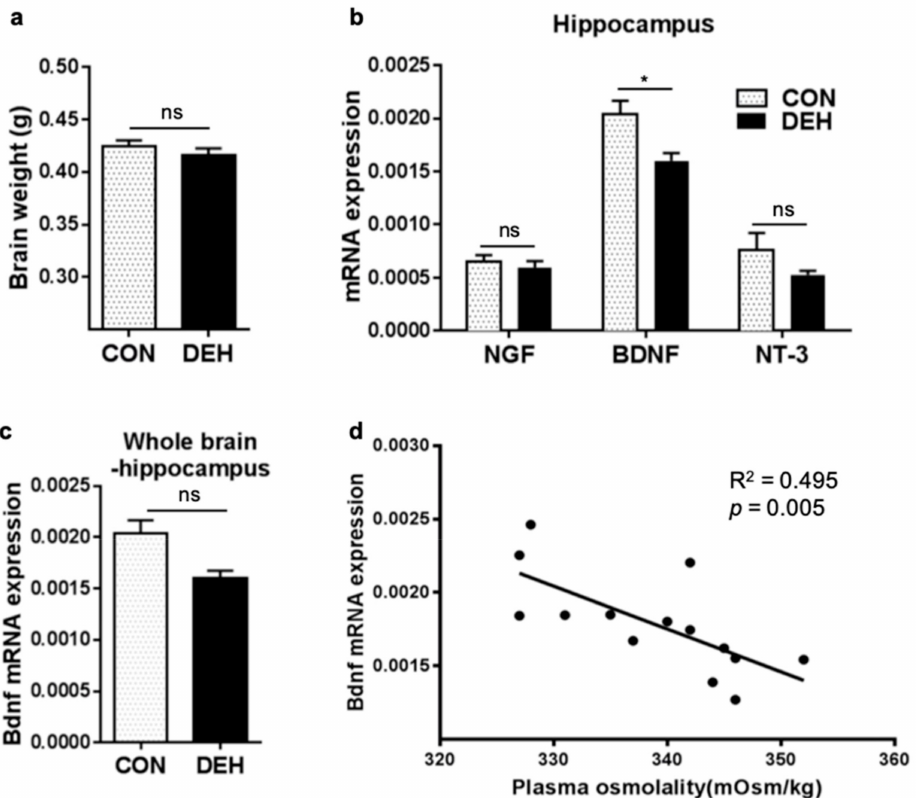
Figure 3. Dehydration alters hippocampal brain-derived neurotrophic factor (Bdnf) expression levels in young mice. ( a ) Brain weight was measured after the dehydration experiment in the control (CON) and dehydration group (DEH). ( b ) The expression of neurotrophic factors in the hippocampus and ( c ) of Bdnf mRNA in other brain regions (excluding the hippocampus) were assessed via qPCR. ( d ) The relationship between hippocampal Bdnf transcript and plasma osmolality levels was evaluated via a Pearson’s correlation analysis. Data are presented as the mean ± SEM. * p < 0.05 versus CON group according to a Student’s t -test. R 2 and p-values were calculated via a Pearson’s correlation analysis. NS, not statistically